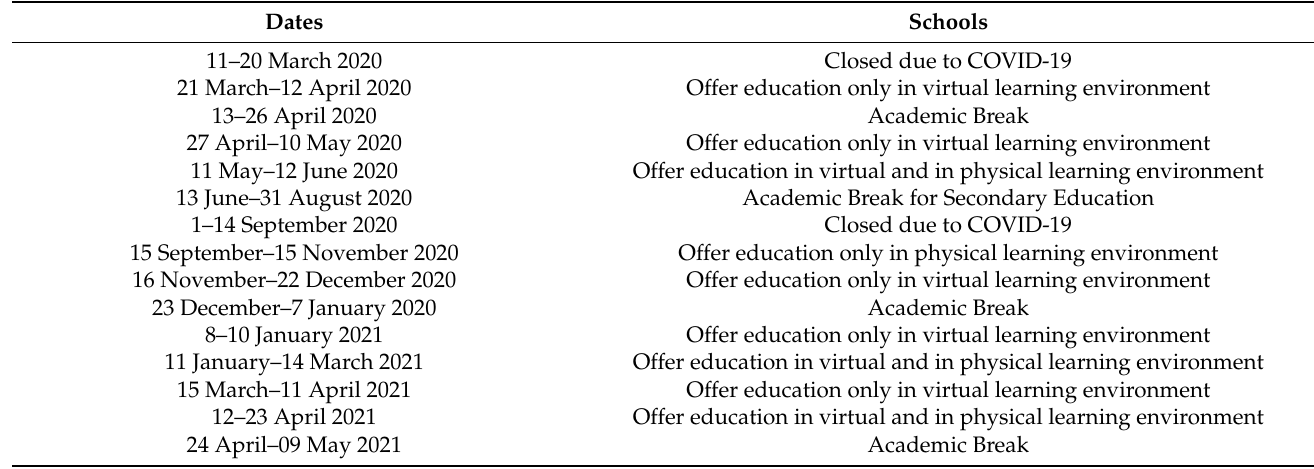
Table 1. Forms of education in Greece during the